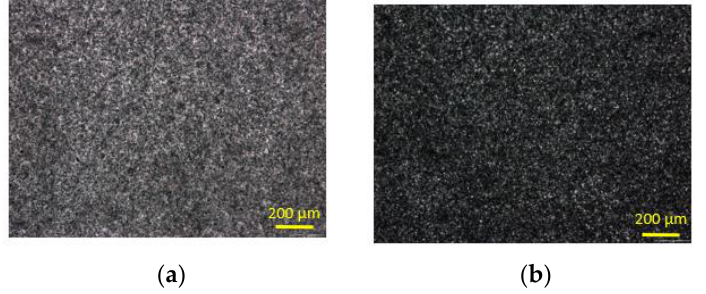
Figure 4. Micrograph of PVB reinforced with MICRO850 at 0.5 wt% ( a ), 2.0 wt% ( b